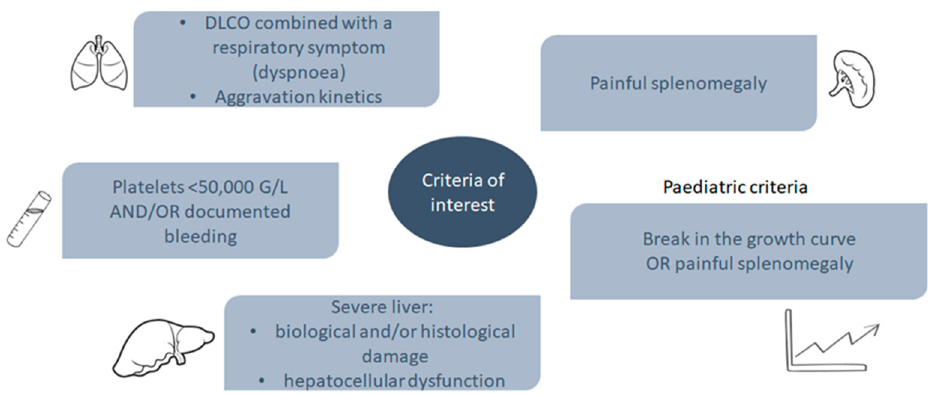
Figure 3. Clinical criteria of interest for patients with ASMD type B or A/B. ASMD, acid sphin- gomyelinase deficiency; DLco, diffusing capacity of the lungs for carbon